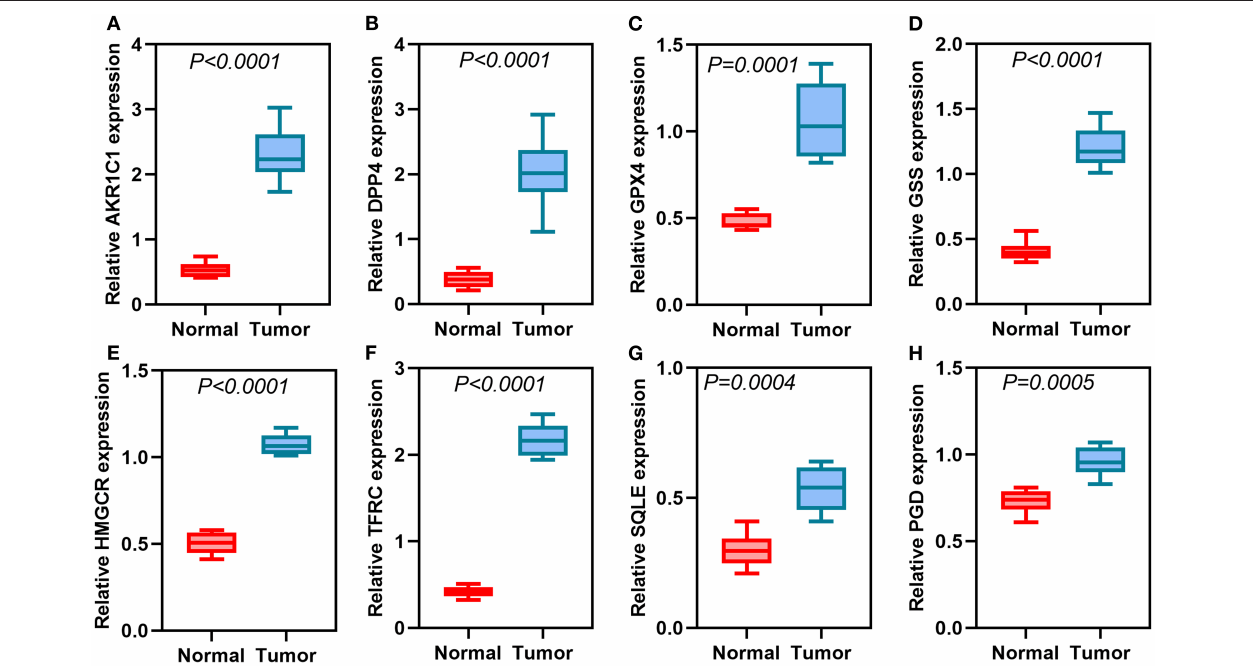
FIGURE 8 | RT-qPCR detecting the mRNA expression of (A) AKR1C1, (B) DPP4, (C) GPX4, (D) GSS, (E) HMGCR, (F) TFRC, (G) SQLE, and (H) PGD in thyroid cancer and normal tissues.